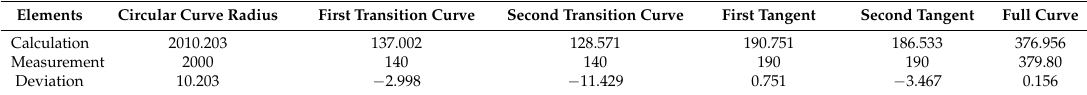
Table 3. The calculation results compared with the railway measured data